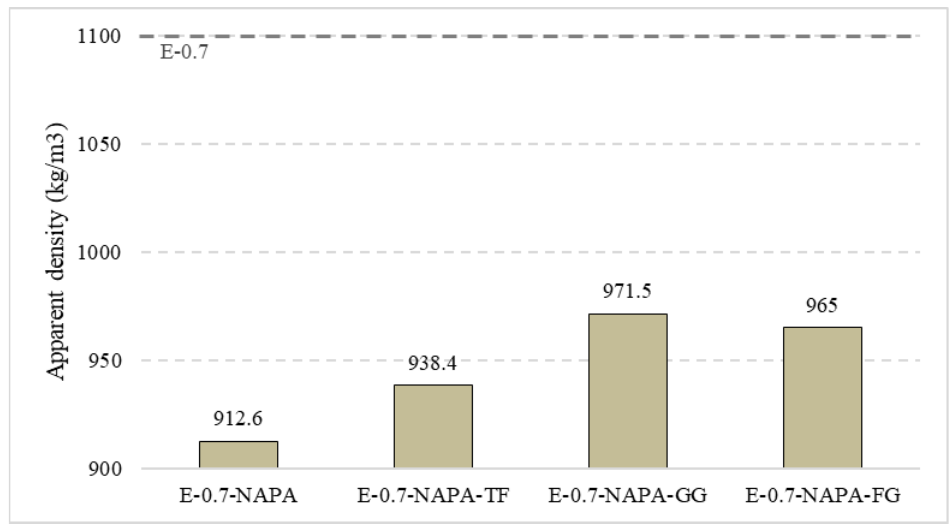
Figure 17. Apparent density (kg/m 3 ).